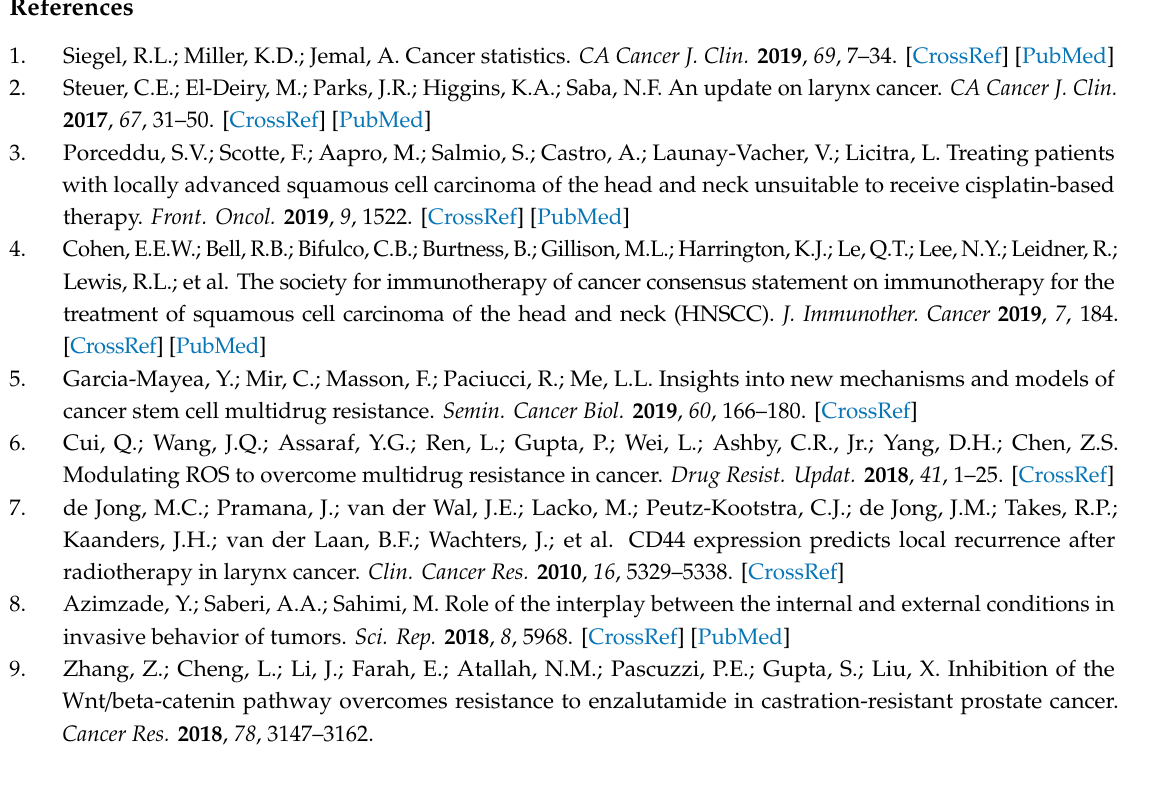
Figure S1: TSPAN1 depletion inhibits cell proliferation, Figure S2: TSPAN1 inhibition under an alternative specific mix of 30 siRNA (siPool) sensitizes HNSCC cells to the e ff ects of CDDP, Figure S3: TSPAN1 inhibition sensitizes HNSCC cells to the e ff ects of dasatinib, Figure S4: TSPAN1 inhibition modulates di ff erent pathways. Figure S5: Phenotypic characteristics, TSPAN1 levels, and proliferative potential of tumors formed in mice. Figure S6: Ex vivo analysis of micrometastases under TSPAN1 depletion, Figure S7: TSPAN1 expression at mRNA level, Figure S8: Original western blot figures (uncropped blots), Table S1: General characteristics of the 106 patients analyzed in this study, Table S2. Proteins identified in the proteomic study. An ANOVA test was performed to determine proteins significantly dysregulated between CCL-138, CCL-138-R and CCL-138 CSCs, Table S3. ANOVA test to determine proteins significantly dysregulated between CCL-138, CCL-138-R and CCL-138 CSCs, Table S4. Post-Hoc analysis which shows the di ff erences observed between CCL-138-R and CCL-138 cells, Table S5. Post-Hoc analysis which shows the di ff erences observed between CCL-138 CSCs and CCL-138 cells, Table S6: Proteins commonly deregulated in CCL-138-R cells and CSCs versus CCL-138, Table S7: Clinical and pathological characteristics of the patients analyzed in this